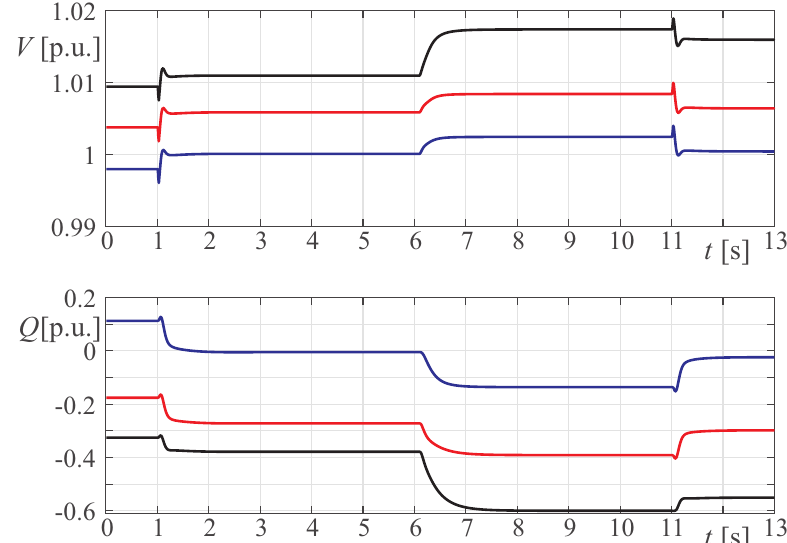
Figure 8. First simulation, Feeder 2: time evolution of the nodal voltage amplitudes ( V 18 blue, V 21 red, V 24 black) and PV reactive powers ( Q DG